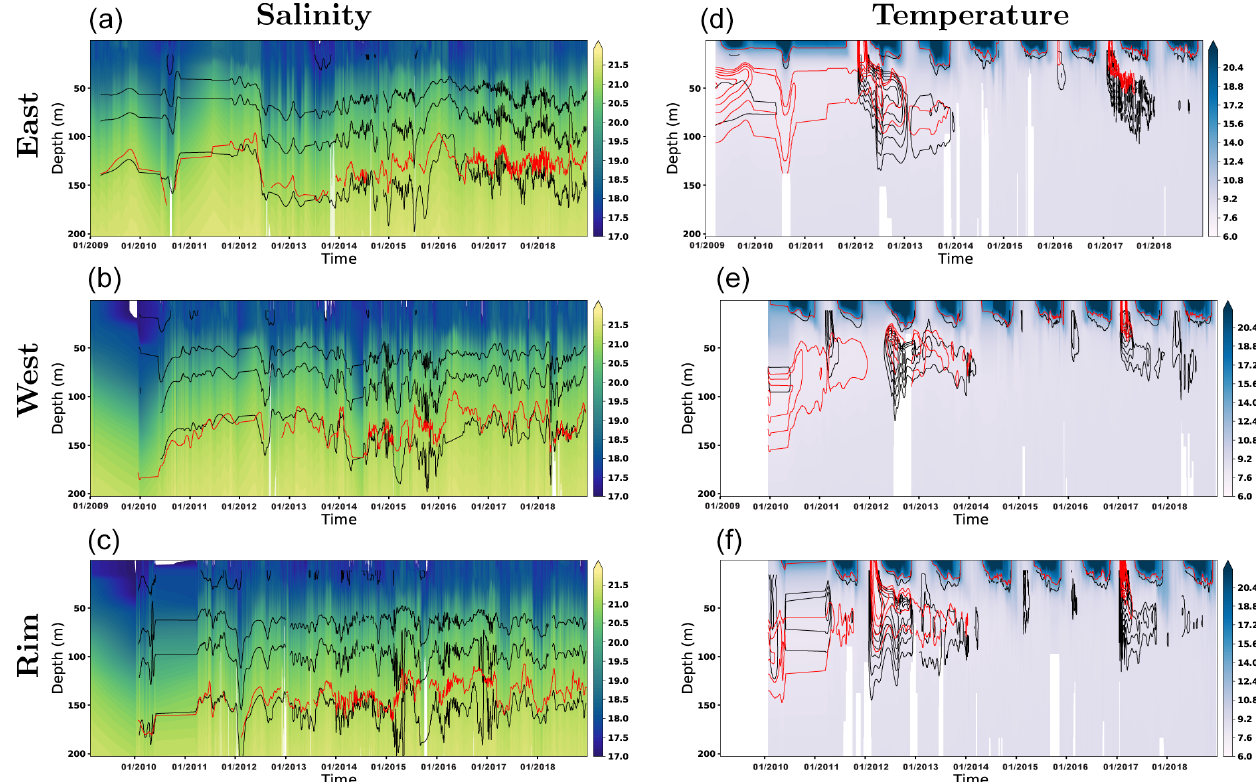
Figure 7. CTD profiles of salinity (left column) and temperature (right column) for the three subregions shown in Fig. 1: (a) “east” region, (b) “west” region and (c) “rim” region. Model results were shown as the background fill image for each figure. Argo and model results were also shown by a contour line (17 to 21 for Argo salinity; 21 for model salinity; 7 to 8.5 and 15 ◦ C for the temperature), with the black line for the Argo data and the red line for the